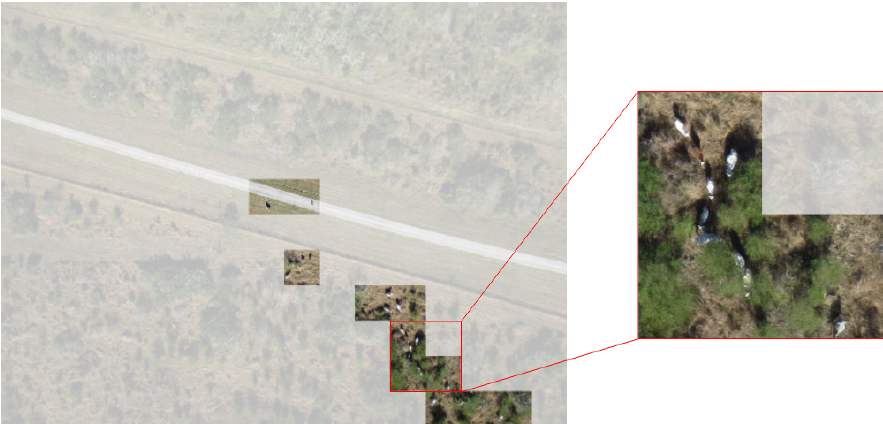
Figure 5. An example of sparsity in our dataset. Translucent area is the background. Transparent patches are labeled as foreground information, and represent only a small percentage of the total